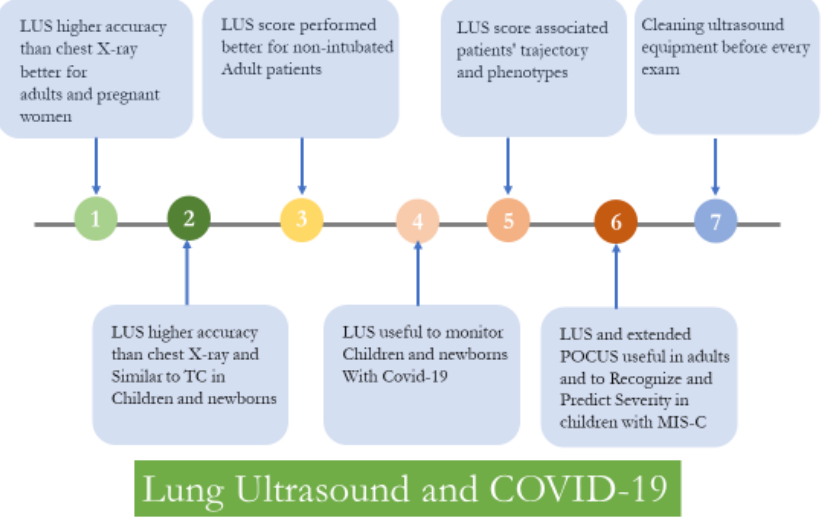
Figure 1. Main steps in the implementation of lung ultrasound in patients with COVID-19. In the largest international multicenter observational study, involving 20 US and Euro- pean hospitals with patients suspected of having COVID-19, LUS patterns of probability integrated with patients’ characteristics allowed the diagnosis of COVID-19 pneumonia at the bedside with high accuracy, according to the different clinical phenotypes